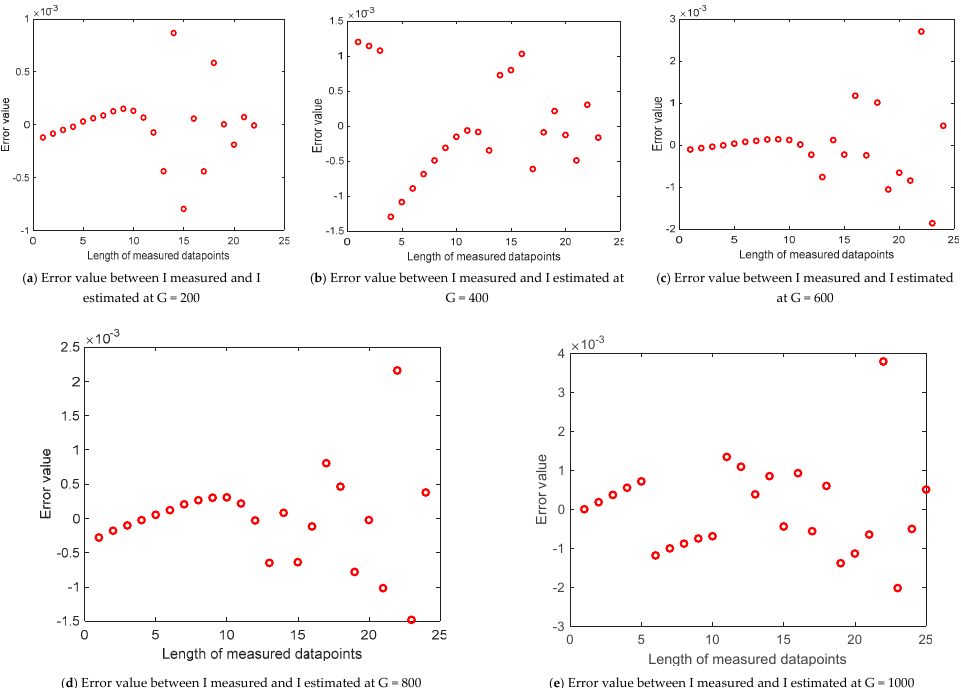
( d ) Error value between I measured and I estimated at G = 800 ( e ) Error value between I measured and I estimated at G = 1000 Figure 24. Depiction of error value between all I measured and estimated data on the SM55 module at different irradiance.